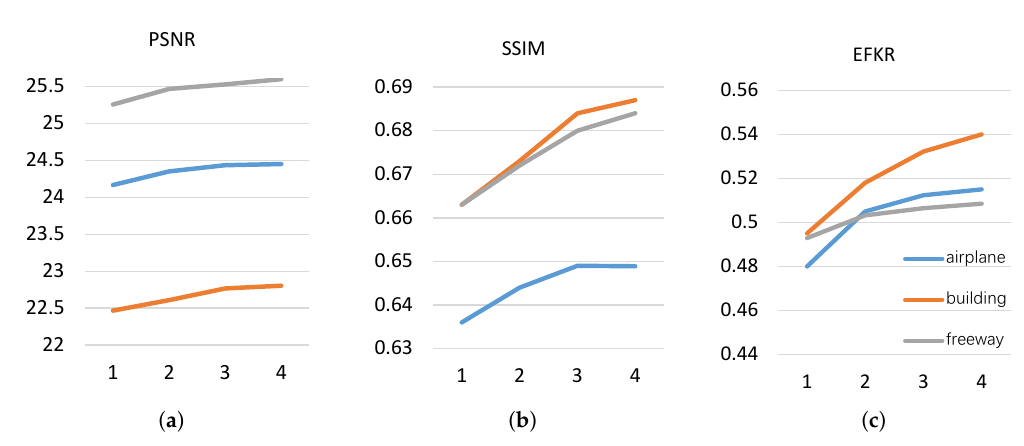
Figure 13. Test results of proposed network with scale 1, 2, 3, 4 when nosie level L =